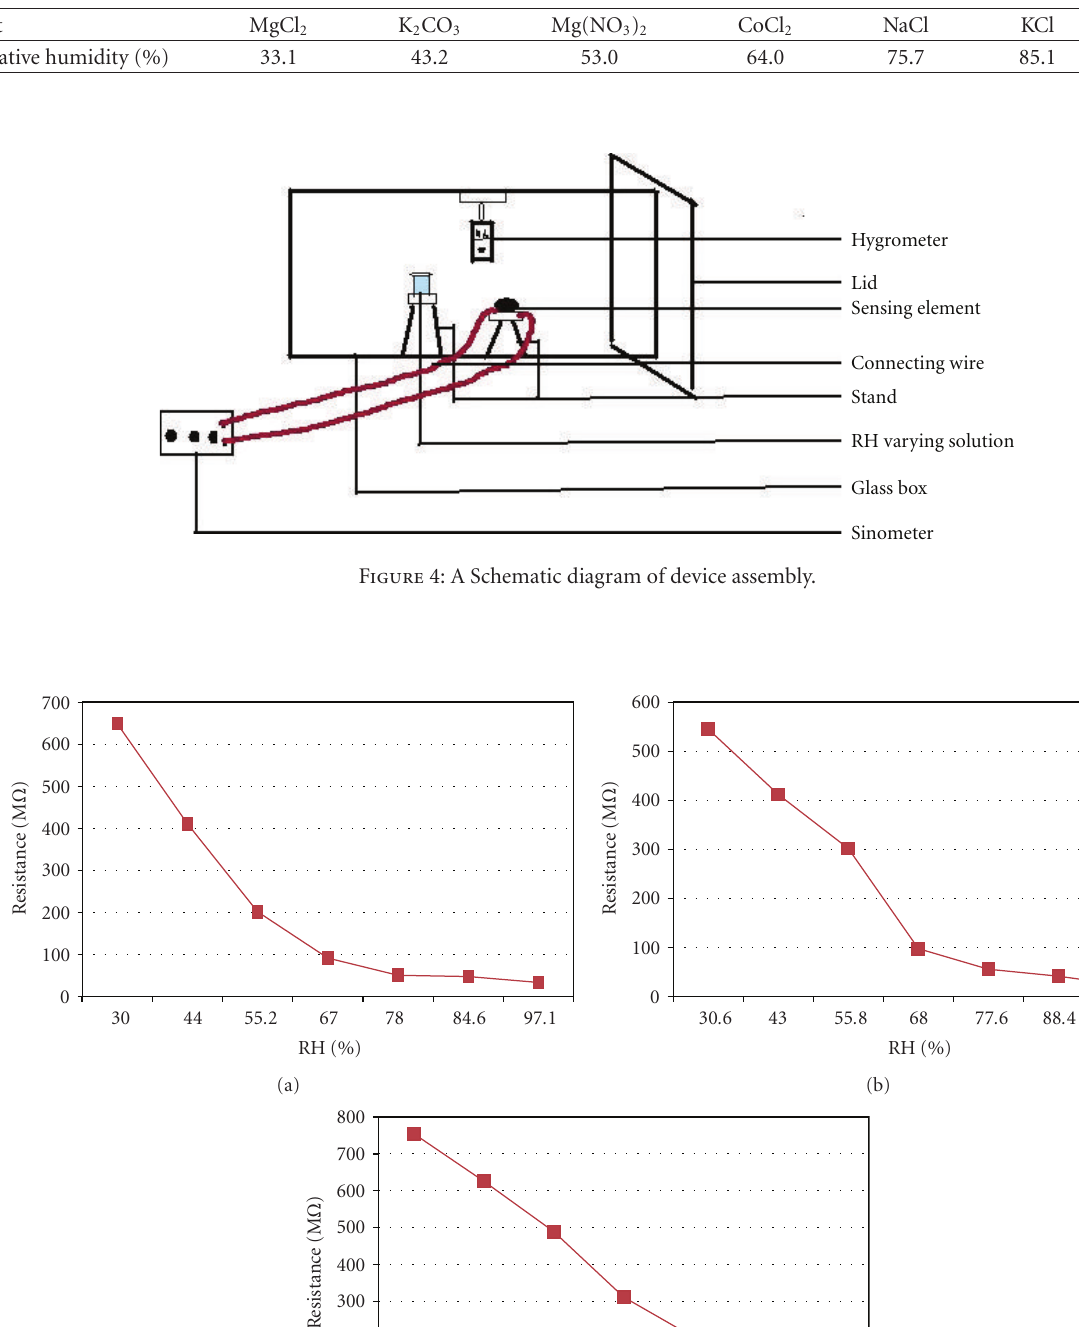
Table 2: Relative humidity above saturated salt solutions.